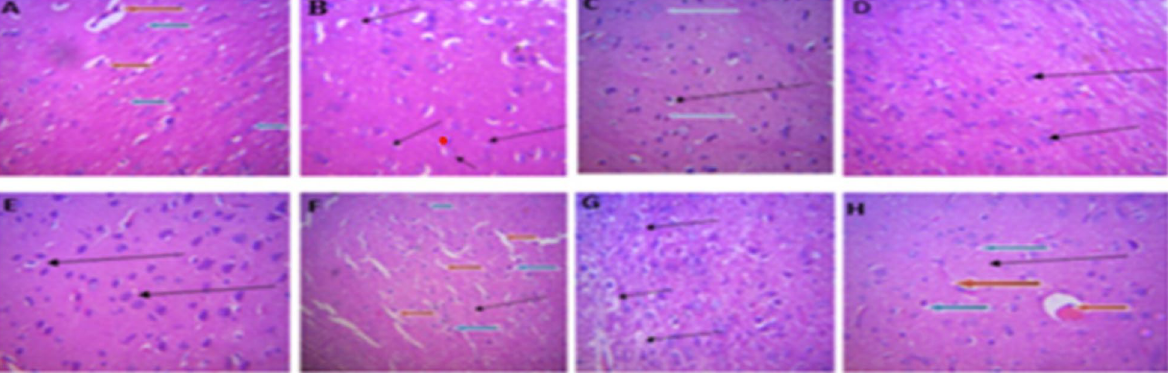
Fig. 5 Photomicrographs obtained from hematoxylin- and eosin-stained cerebral cortex sections of the rat treated with KBrO3 and AEAC and or quercetin. Group A: control showed normal neuronal architecture, group B was administered KBrO3 only and shows chromatolysis and severe necrosis of the neuronal cells, groups C, D, and E groups administered AEAC alone in graded doses and quercetin alone showed normal neuronal architecture. The groups F, G, and H co-administered KBrO3 and AEAC/ or quercetin shows some normal cellular architecture, with modest degeneration of cells in the cerebral